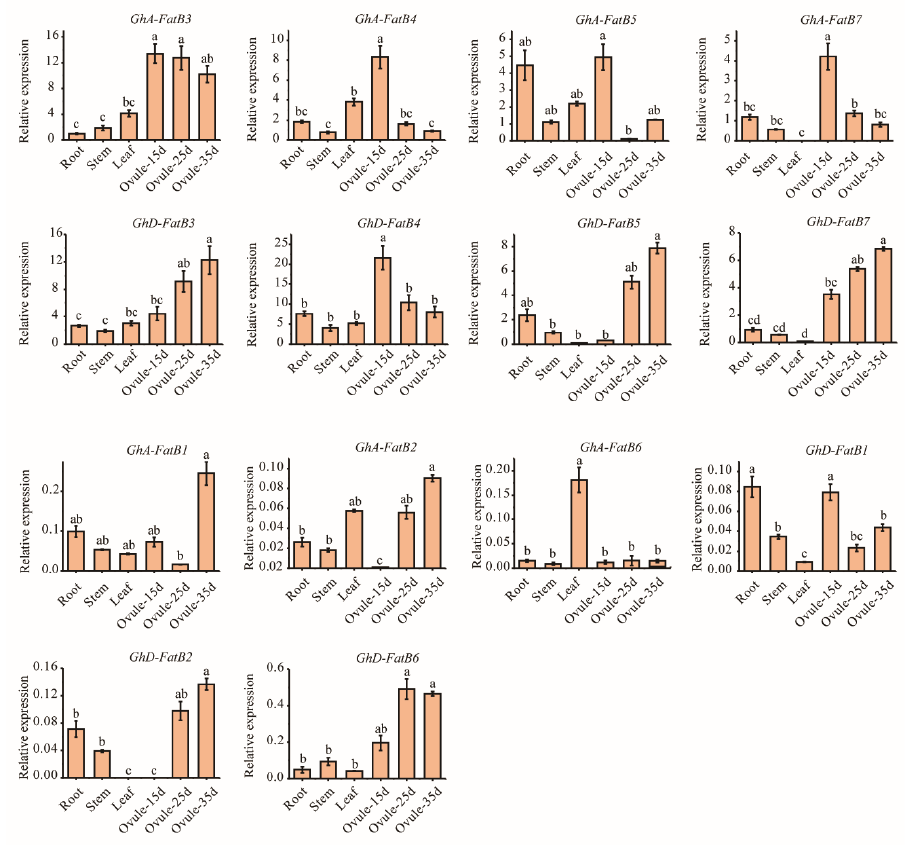
Figure 5. Expression patterns of 14 GhFatB genes in various cotton tissues examined by qRT-PCR analysis. The method of 2 −Δcq was used in this analysis. Bar charts represent the relative expression levels of GhFatB genes normalized by the internal control genes GhHistone3 and GhEF-1 α measured by qRT- PCR with three biological samples for each tissue. “Ovu - 15d, 25d and 35d” represent the developing ovules at 15, 25 and 35 days after flowering, respectively. Histograms with different small letters are significantly different at 0.05 leve l by Tukey’s test. Coincidentally, the dynamic expression of GhA-FatB3 and GhD-FatB4 in ovules showed a positive association with palmitic acid (C16:0) levels in the developing cotton- seeds (Figure 6). Furthermore, the linear regression coefficient was significant between C16:0 content and GhD-FatB4 expression with r = 0.992. GhA-FatB3 expression and pal- mitic acid accumulation also displayed a positive correlation with r = 0.690. This associa- tion analysis again evidenced that GhA-FatB3 and GhD-FatB4 probably contribute vitally to the biosynthesis and the accumulation of C16:0 in cotton seeds.